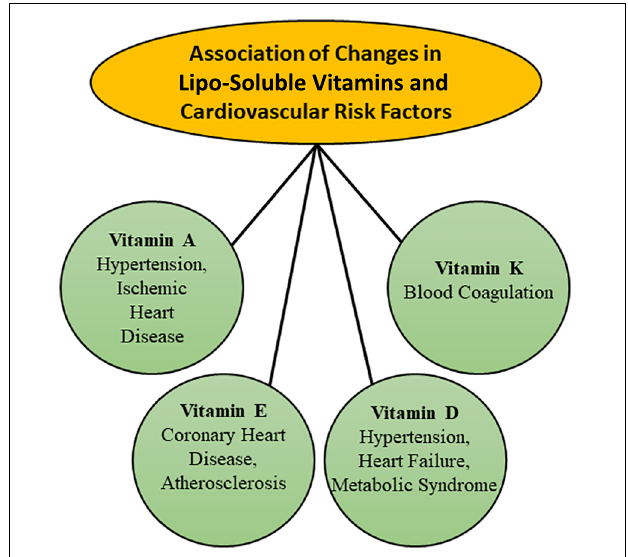
FIGURE 1 | Associations of changes in plasma concentration of different lipo-soluble vitamins with various risk factors for the development of cardiovascular disease.